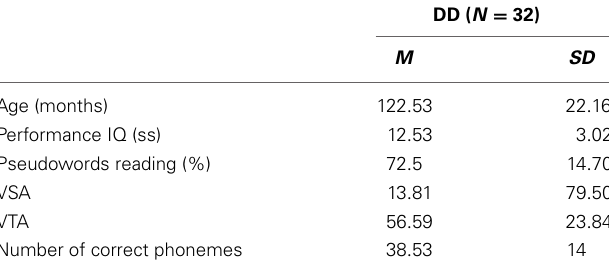
relationship of reading performance and visual attentional